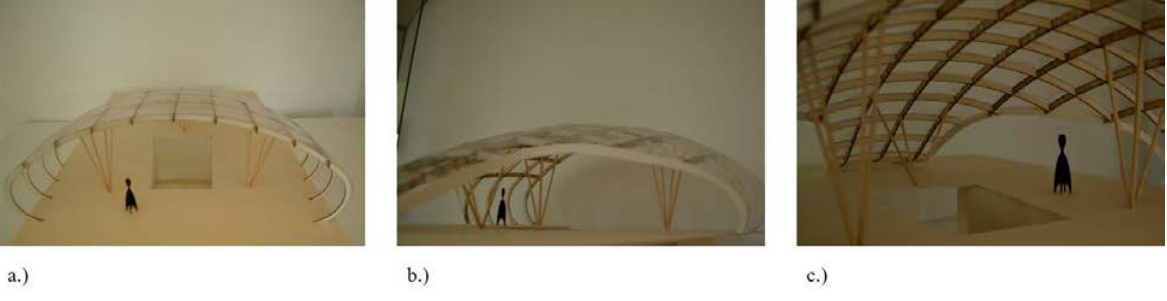
Fig. 9 Final model of the entrance portal “Wings”, front view a.), back view b.), interior